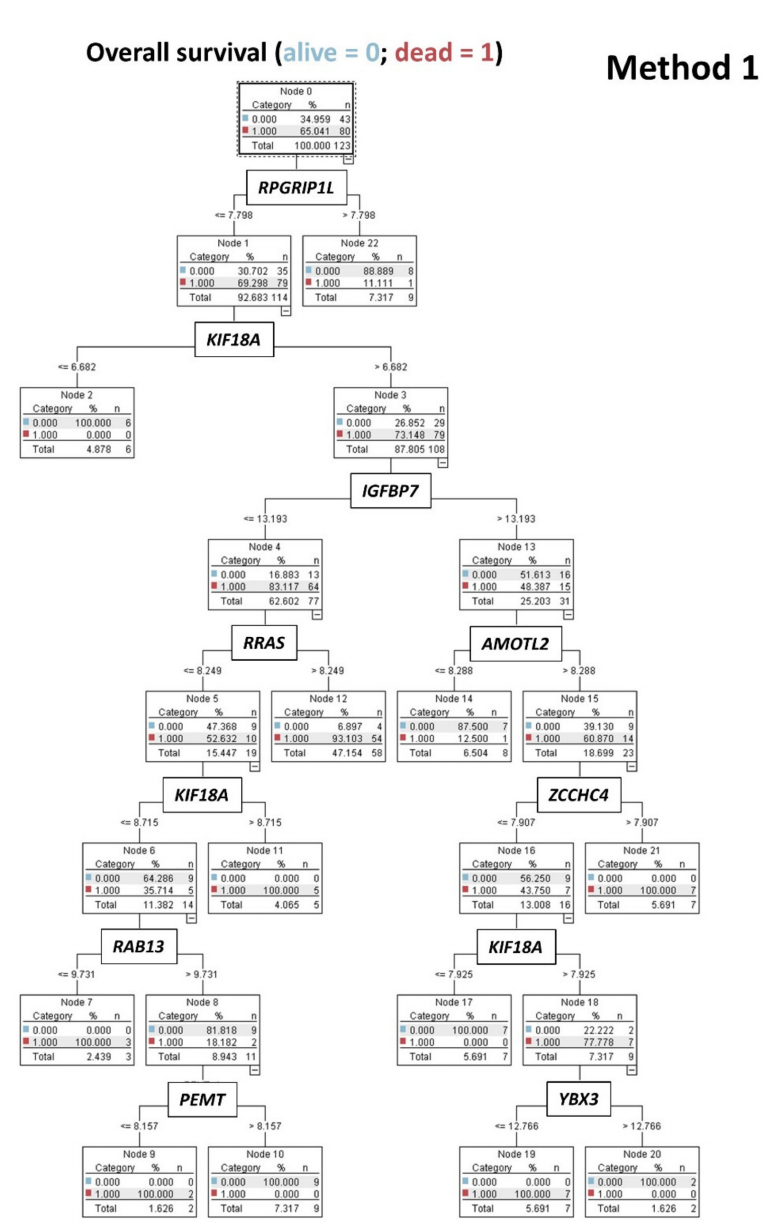
Figure 12. C5.0 decision tree model. A decision tree successfully modeled the overall survival outcome (dead/alive) using the 19 genes, previously identified in the neural network analysis (Figure 5, Method 1). This model uses the C5.0 algorithm to build either a decision tree or a rule set. A C5.0 model works by splitting the sample based on the field that provides the maximum information gain. Each subsample defined by the first split is then split again, usually based on a different field, and the process repeats until the subsamples cannot be split any further. Finally, the lowest-level splits are reexamined, and those that do not contribute significantly to the value are removed. In this model, the target field (variable) must be categorical (i.e., nominal or ordinal, such as de overall survival outcome as dead vs. alive). The input fields (predictors) can be of any type (in our analysis, the 19 genes were entered as quantitative gene expression). The C5.0 models are quite robust in the presence of problems such as missing data and large numbers of input fields. The C5.0 tree shows how using only the gene expression of 9 genes, the overall survival outcome as dead or alive can be predicted with high